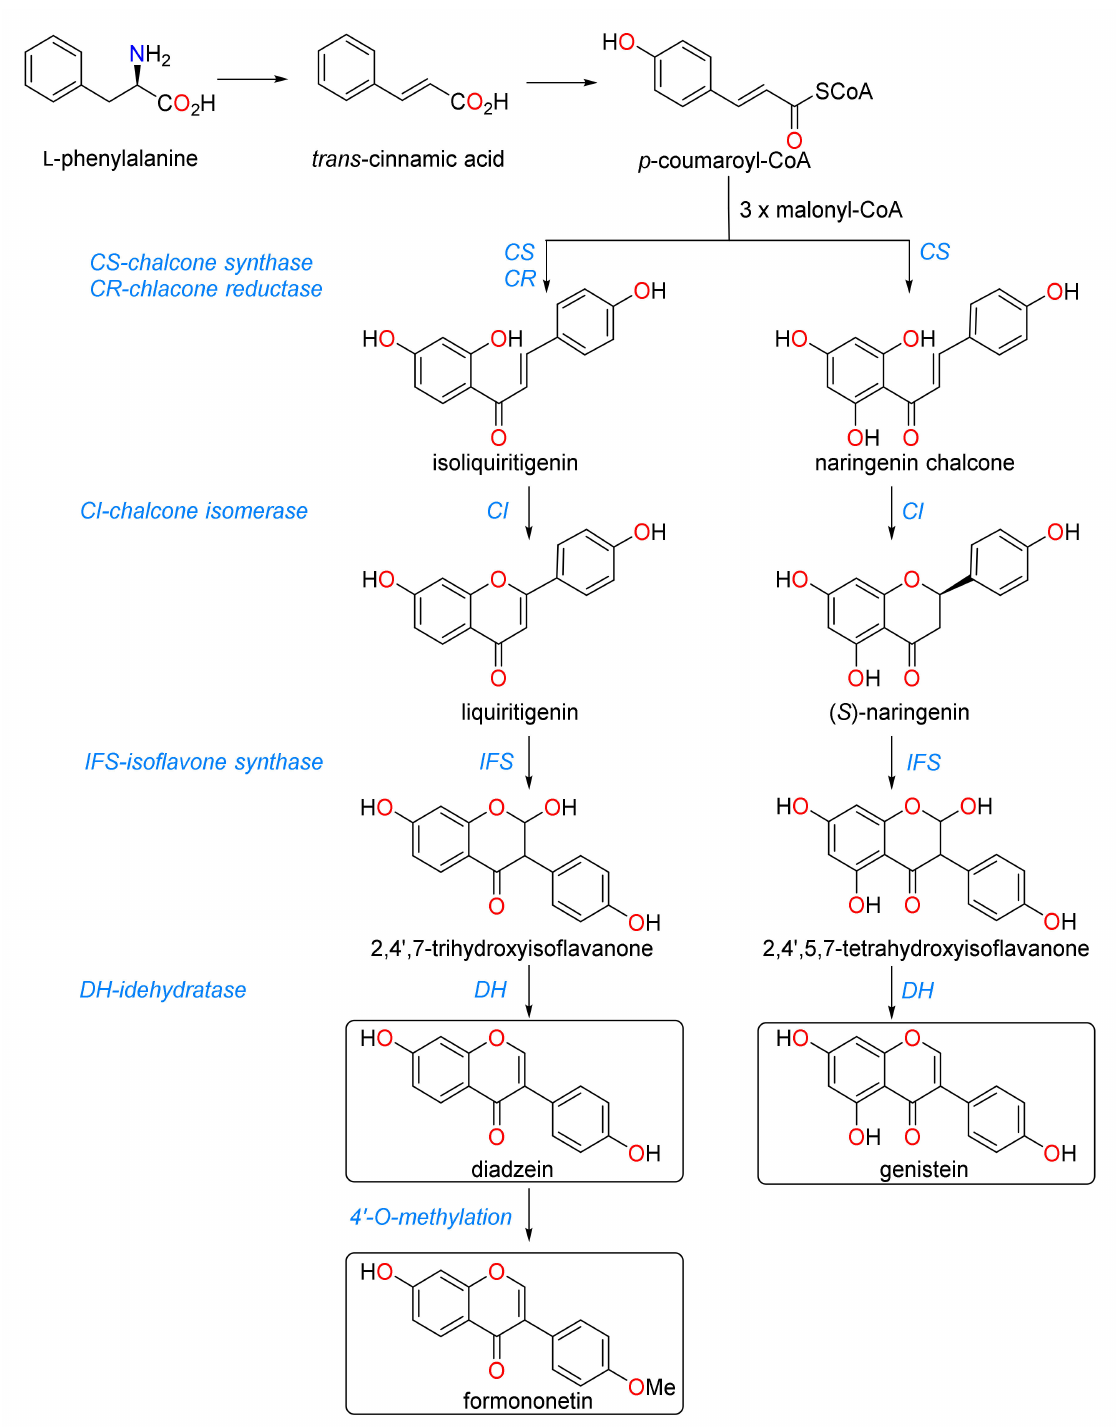
Figure 4. Biosynthetic pathway leading to the formation of various isoflavones including phytoestrogenic isoflavones (boxed)